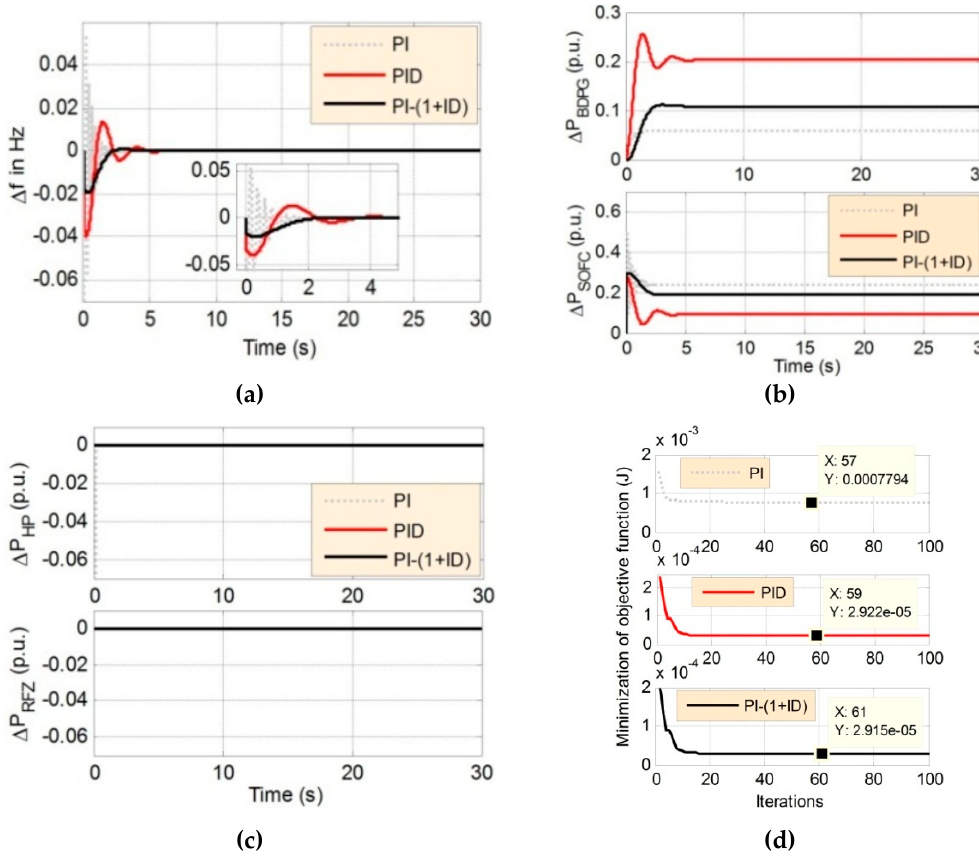
Figure 4. Comparative system dynamics analysis of different controllers (proportional-integral ( PI ), PI -derivative ( PID ), PI-(1+ID) ) ( a ) deviation in system frequency ( Δ f ), ( b ) change in extractable power of bio-diesel power generator ( BDPG ) and SOFC , ( c ) change in extractable power of HP and RFZ , ( d ) Comparative converged objective function ( J min ).